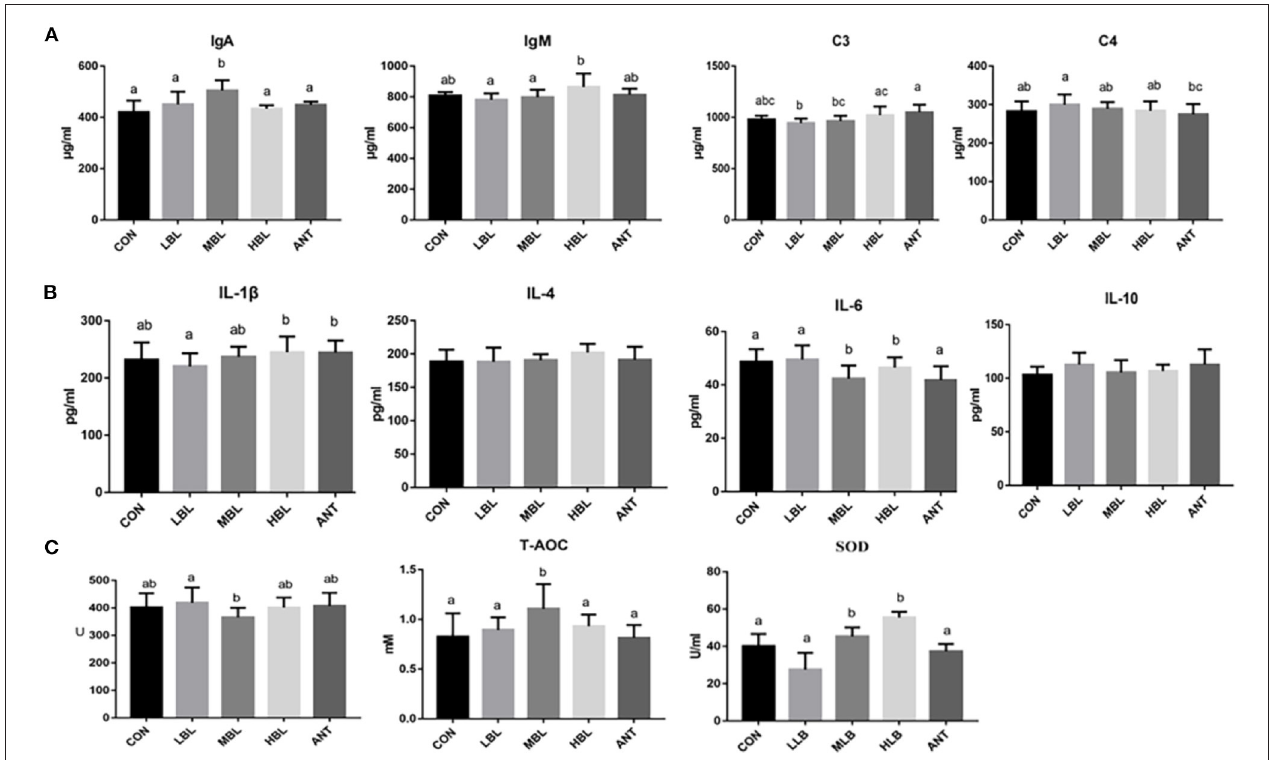
FIGURE 1 | Effects of B. licheniformis on inflammatory factors, immune indices, and antioxidant indices of Pekin ducks. (A) immune indices; (B) inflammatory factors; (C) antioxidant indices. CON, control group, basal diet; LLB, basal diet + 200 mg/kg B. licheniformis ; MLB, basal diet + 400 mg/kg B. licheniformis ; HLB, basal diet + 800 mg/kg B. licheniformis ; ANT, basal diet + 150 mg/kg aureomycin.